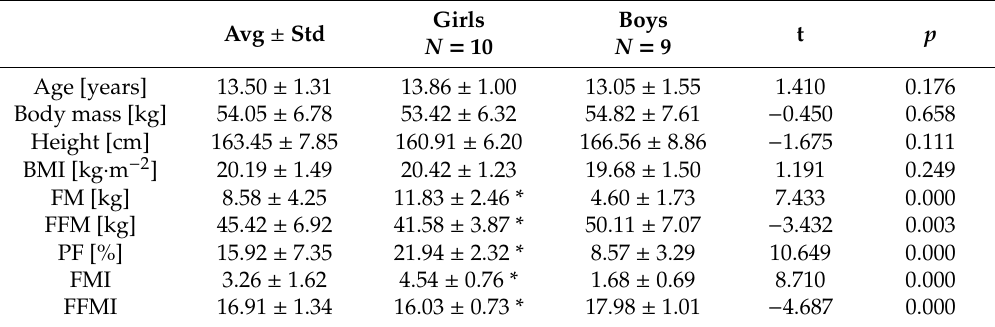
Table 1. Physical characteristics of examined group (mean ± SD, t, p